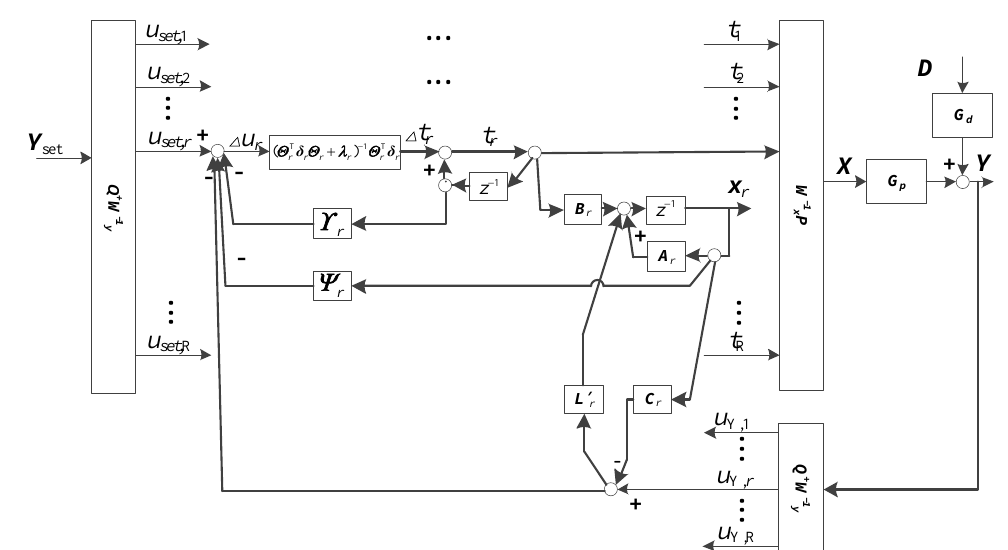
Figure 4. The control structure with disturbance model and observer.